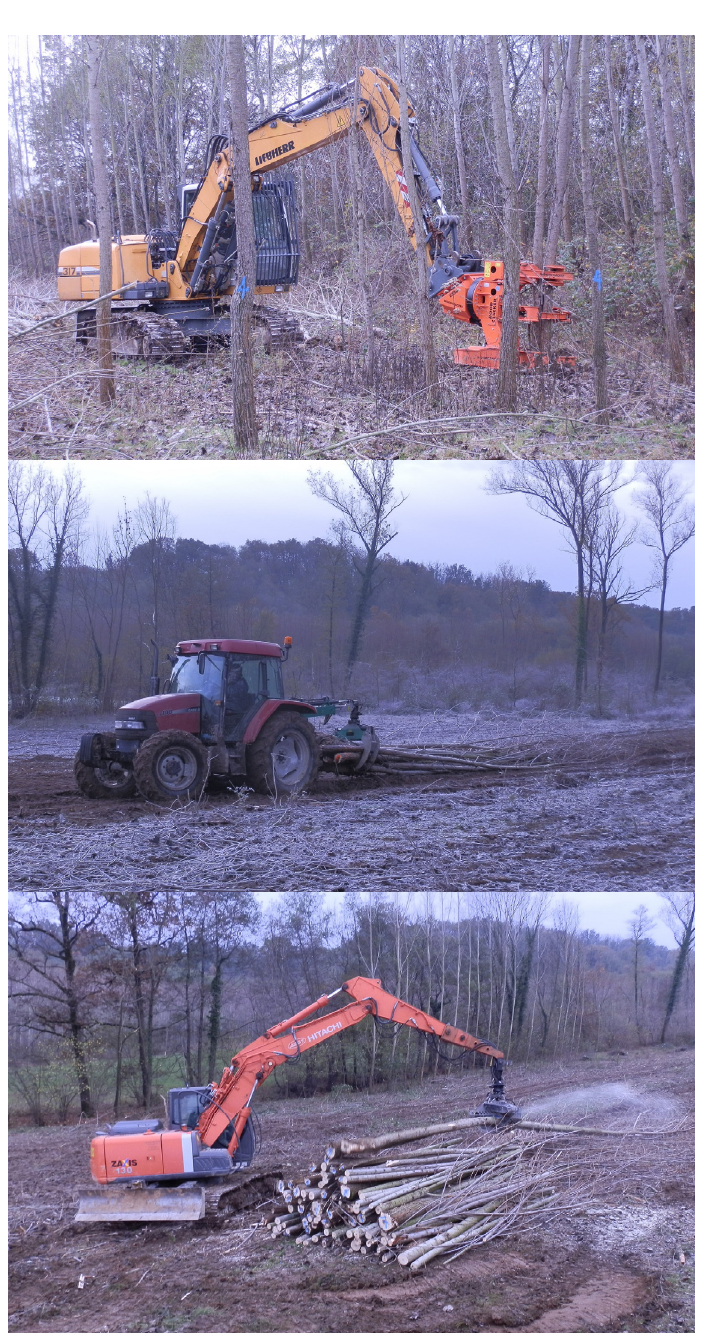
Figure 1. Felling and bunching trees with the excavator-based feller-buncher ( Top ); skidding bunches with the forestry-fitted farm tractor ( Middle ); crosscutting stems into 4-m logs with the excavator-based grapple saw ( Bottom ).